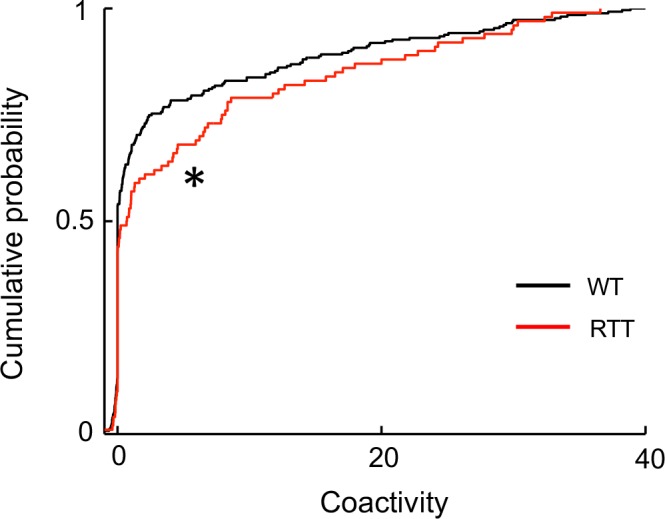
Run-silent cells in RTT mice displayed enhanced firing synchrony in ripple events.The plot shows cumulative distribution of coactivity for pairs of run-silent cells in WT and RTT mice within ripple events, combined from Pre-run and Post-run in both the novel and familiar environments. Number of pairs: N = 268 (WT), 107 (RTT). *p=0.017, Wilcoxon ranksum test.